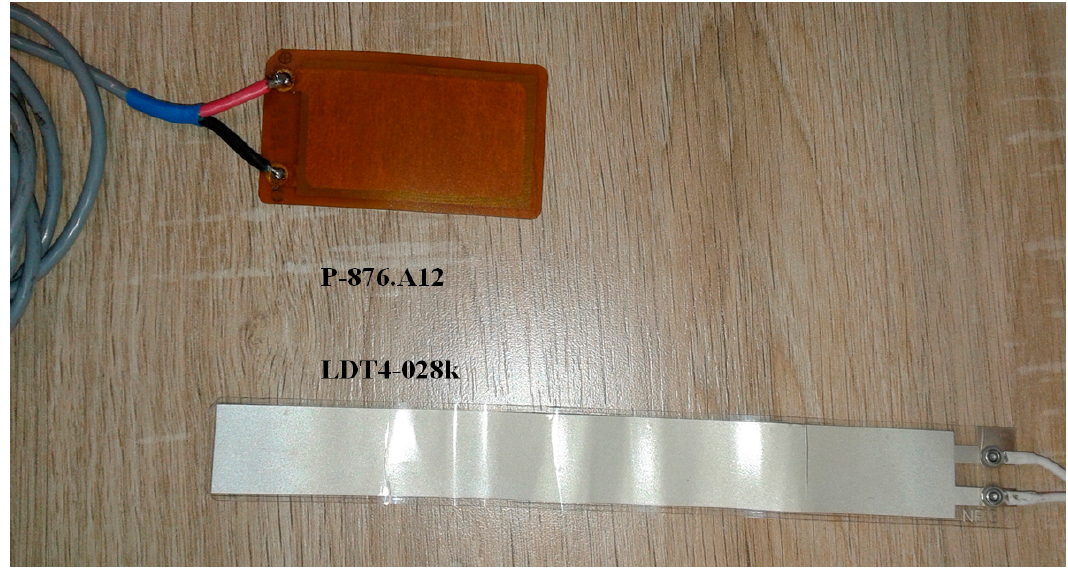
Figure 1. The P-876.A12 sensor [28] and LDT4-028k sensor [29].